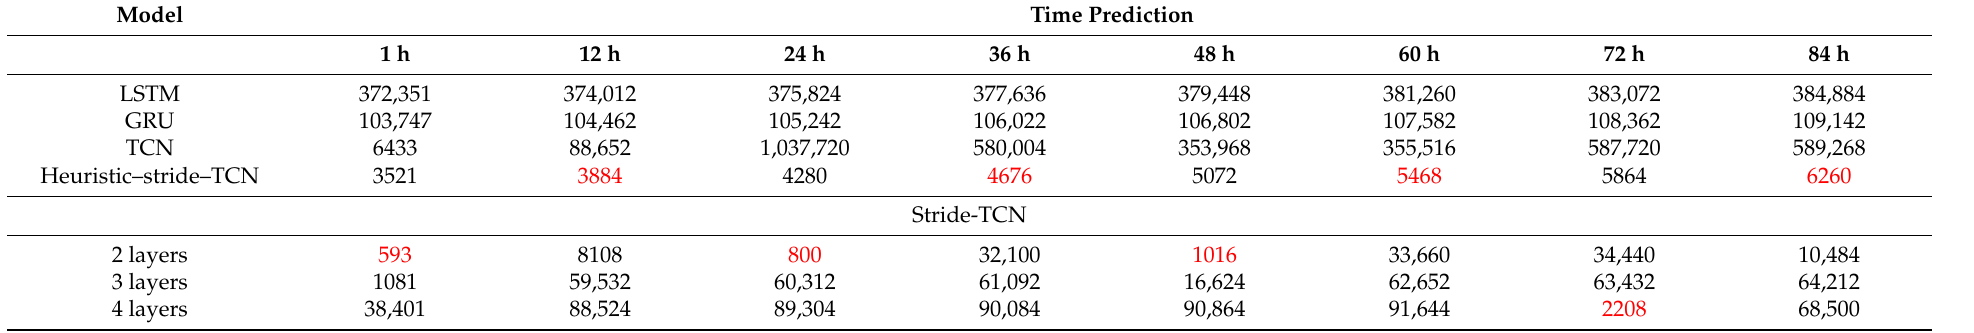
Table 9. Models’ complexity in CNU dataset (dataset 3), demonstrated by the number of parameters.